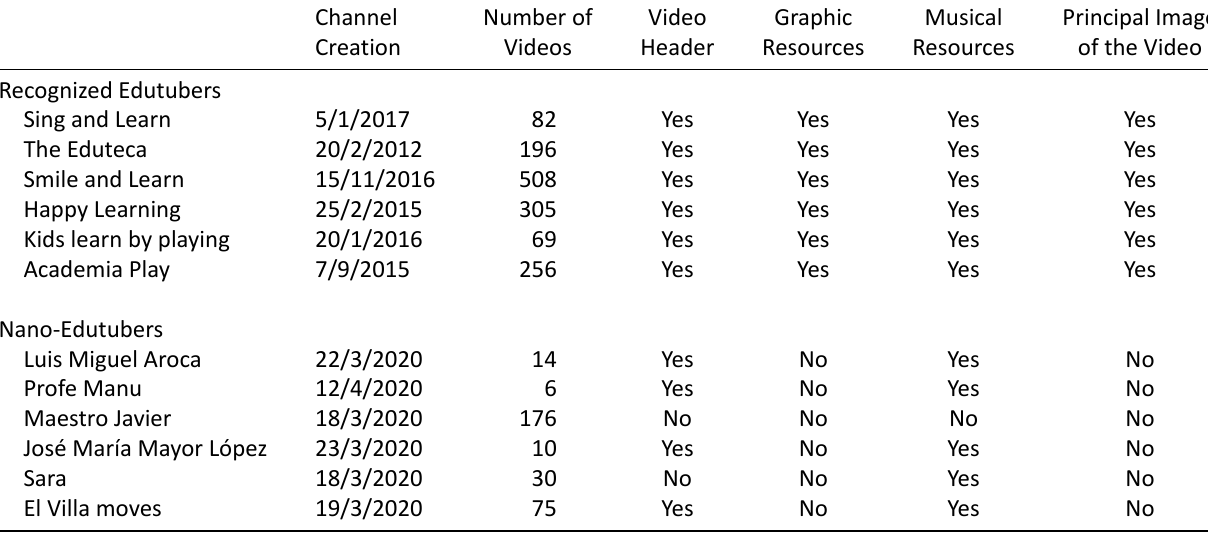
Table 3. Characteristics of the transmedia production of